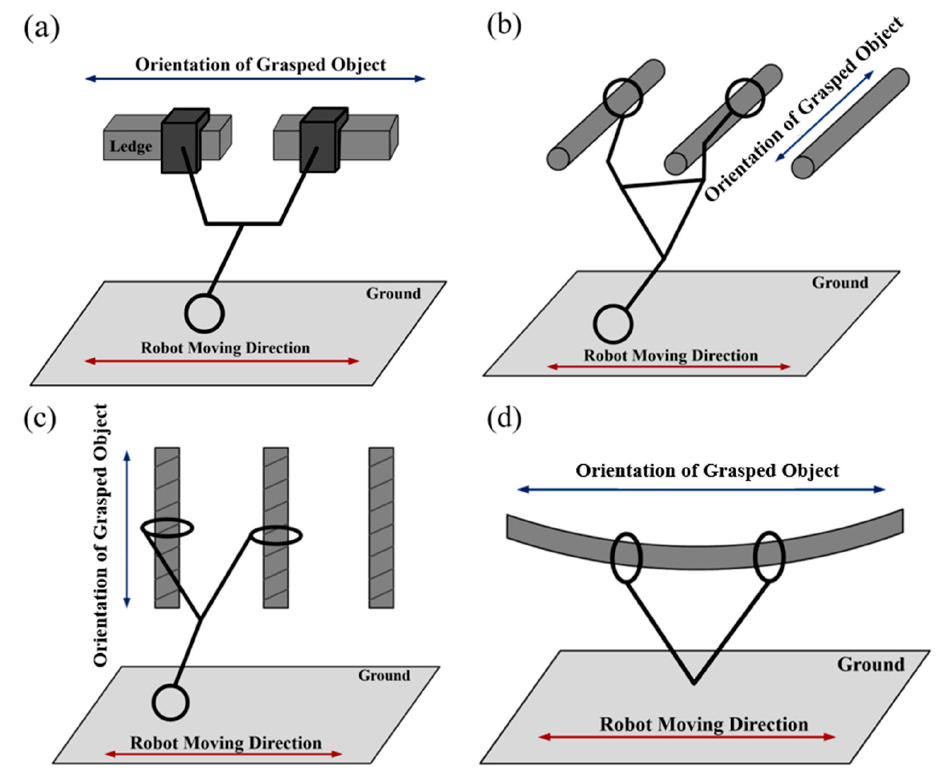
Figure 1. Illustration of principles underlying brachiation robots. ( a ) Proposed robot; ( b ) Gorilla robot III [16]; ( c ) MonkeyBot [23]; ( d ) Tarzan [25]. Table 1. Comparison of brachiation robots and associated movement constraints.